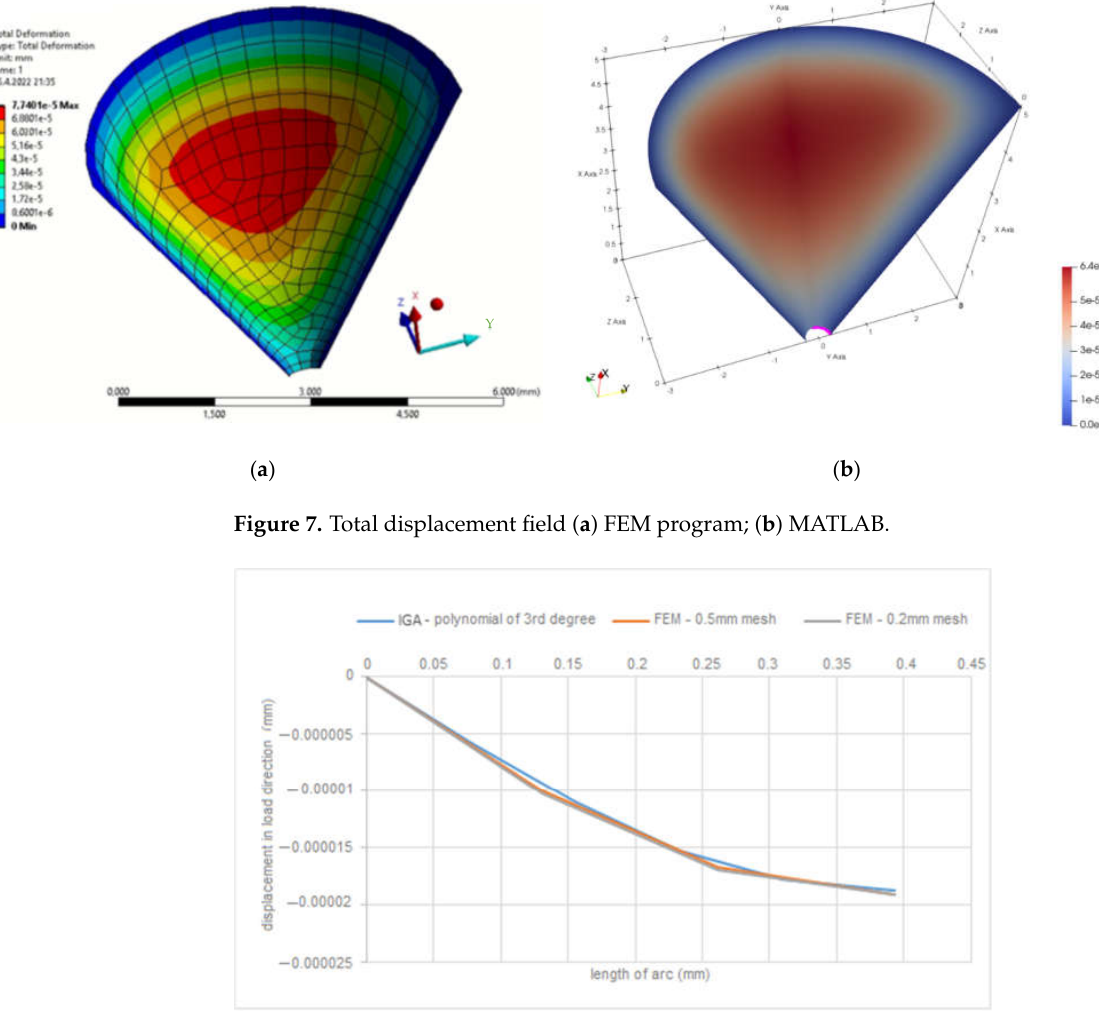
Figure 6. Displacement due to load in x direction ( a ) FEM program; ( b ) MATLAB.